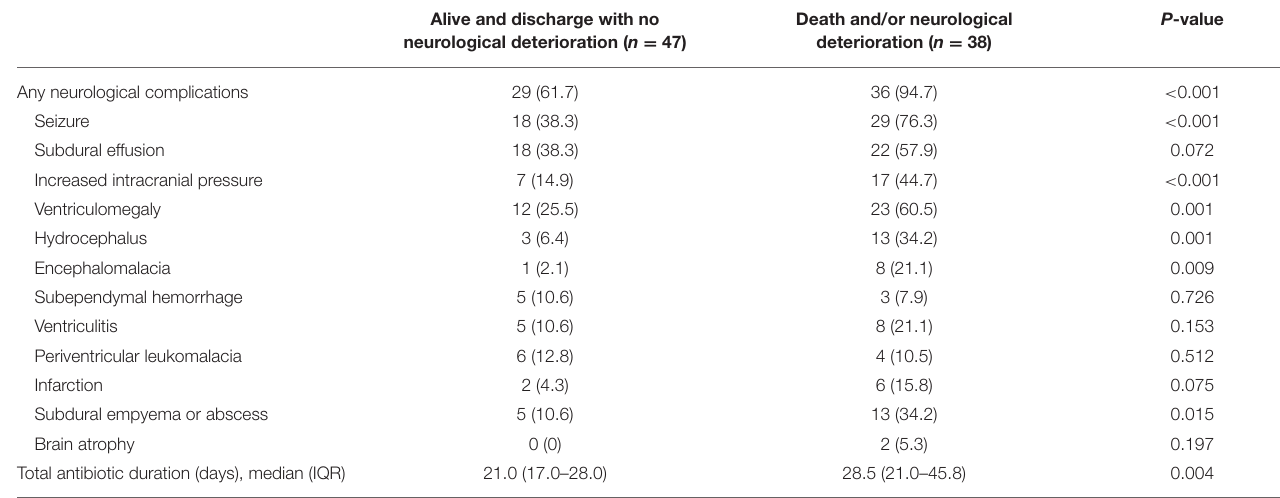
TABLE 2 | Neurological complications in young infants with acute bacterial meningitis.